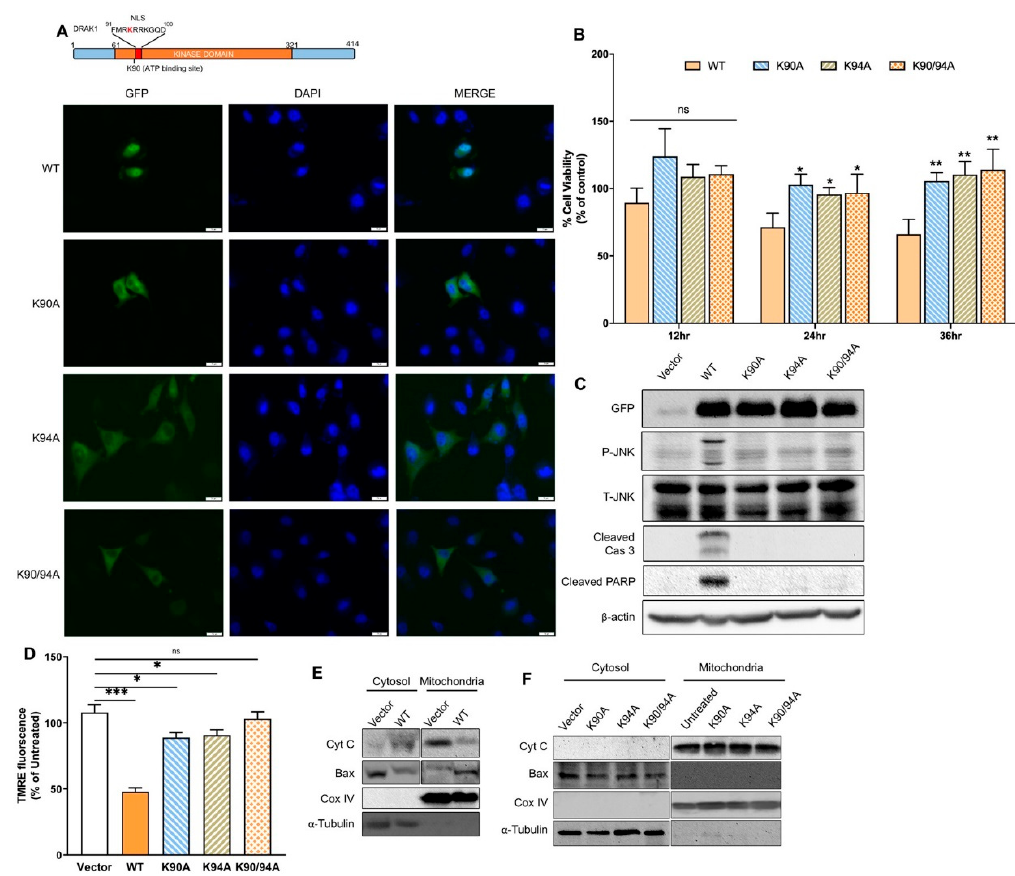
Figure 4. Involvement of DRAK1 kinase activity and nuclear localization in inducing apoptosis. ( A ) Schematic representation of DRAK1 kinase ATP binding site and nuclear localization signal (NLS). PC3 cells expressing GFP-WT or DRAK1 mutants analyzed by immunofluorescence microscopy (scale bar, 20 µ m, representative images are shown), ( B ) Cell viability analyzed by MTT assay at indicated times following transfection, ( C ) Cell lysates probed with indicated antibodies and normalized to β -actin levels, ( D ) Cells were stained with TMRE and fluorescence intensity was normalized to control cells. ( E , F ) PC3 cells were transfected with GFP-WT or DRAK1 mutants and 24 h later mitochondrial and cytosolic fractions were isolated and analyzed as indicated. Values shown are mean ± s.d of triplicate assays. * p < 0.01, ** p < 0.001, *** p < 0.0001, n.s: not significant.